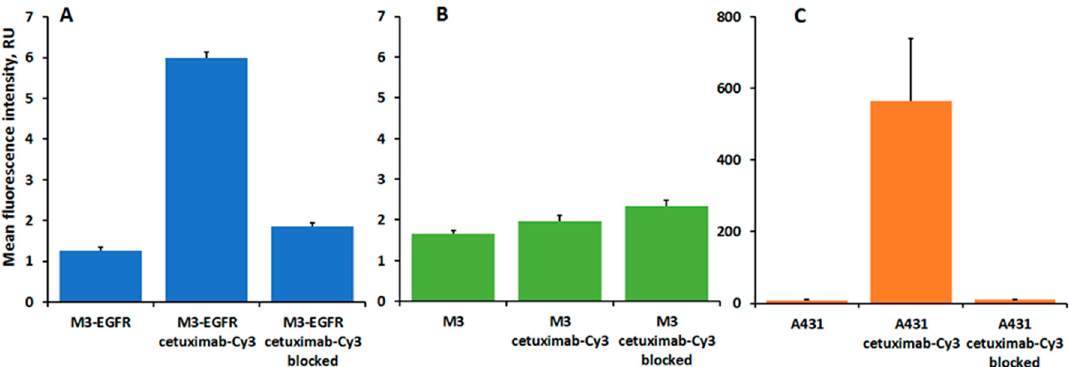
Figure 6. Flow cytometry study measuring interaction of human EGFR specific antibody cetuximab-Cy3 with M3-EGFR ( A ), parental M3 ( B ) and A431 cells ( C ). Cetuximab-Cy3 blocked—refers to cells incubated with Cetuximab-Cy3 in the presence of 1 µM non-labeled cetuximab and 1 µM of human EGF Untreated cells served as autofluorescence controls. Error bars represent standard errors of mean (n = 3–5).